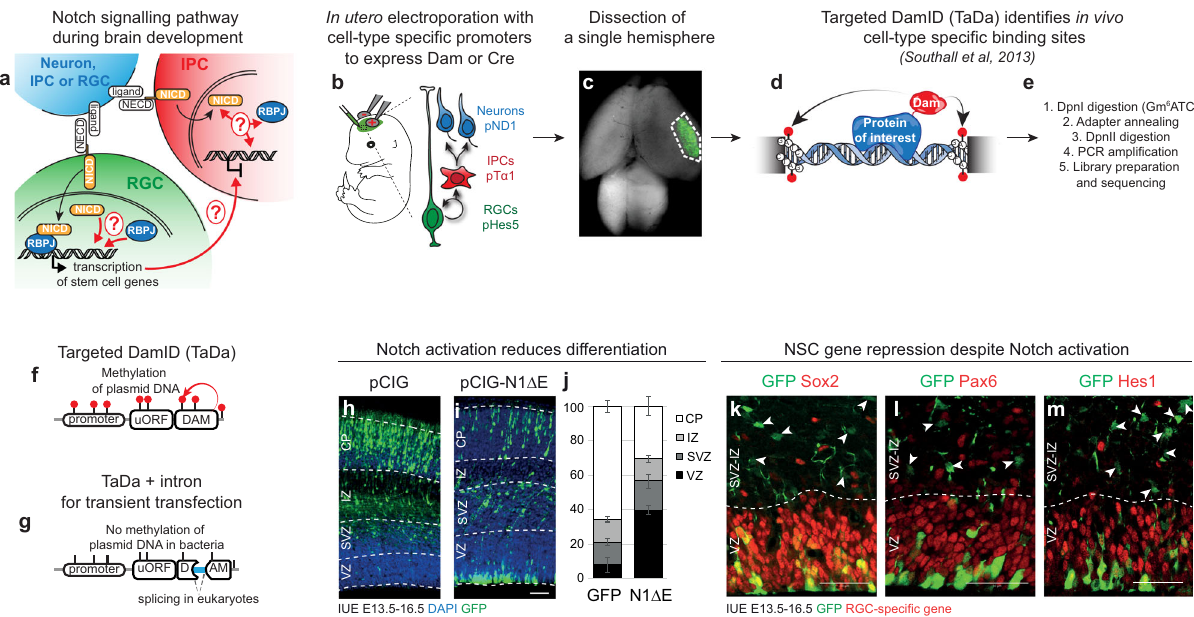
Fig. 1 In utero cell-type speci fi c chromatin pro fi ling. a Overview of the Notch pathway in the developing cortex. b – e Work fl ow of in utero Targeted DamID (TaDa). f , g Schematic overview of TaDa construct and the introduction of an intron to prevent methylation in bacteria and enable transient transfection. h – m . IUE of h pCIG or i pCIG-N1 Δ E labelled with GFP (green) and DAPI (blue) or k – m RGC-speci fi c genes ( Sox2 ( n = 1), Pax6 ( n = 3) or Hes1 ( n = 3), red). j Mean percentage (±s.e.m.) of GFP-positive cells in each region ( n = 3 embryos (pCIG) and n = 5 embryos (pCIG-N1 Δ E)). Source data are provided as a Source Data fi le. Scale bars 100 µ m h , i , and 50 µ m k – m